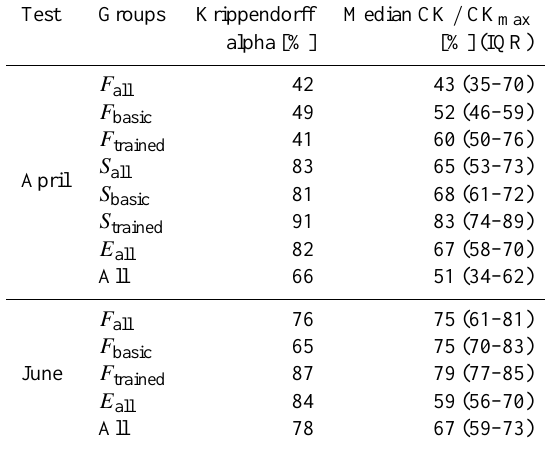
Table 3. Inter-rater reliability statistics for the different groups ( F : farmers, S : students, E : experts, All: all participants) during tests in April and in June. (“ basic ” indicates only basic introduction, “ trained ” indicates more detailed training, “ all ” indicated that both subgroups have been considered.) Krippendorff’s alpha and the Co- hen’s kappa ratio CK / CK max can vary between 100% (perfect agreement) and 0% (no agreement other than that what would be expected by